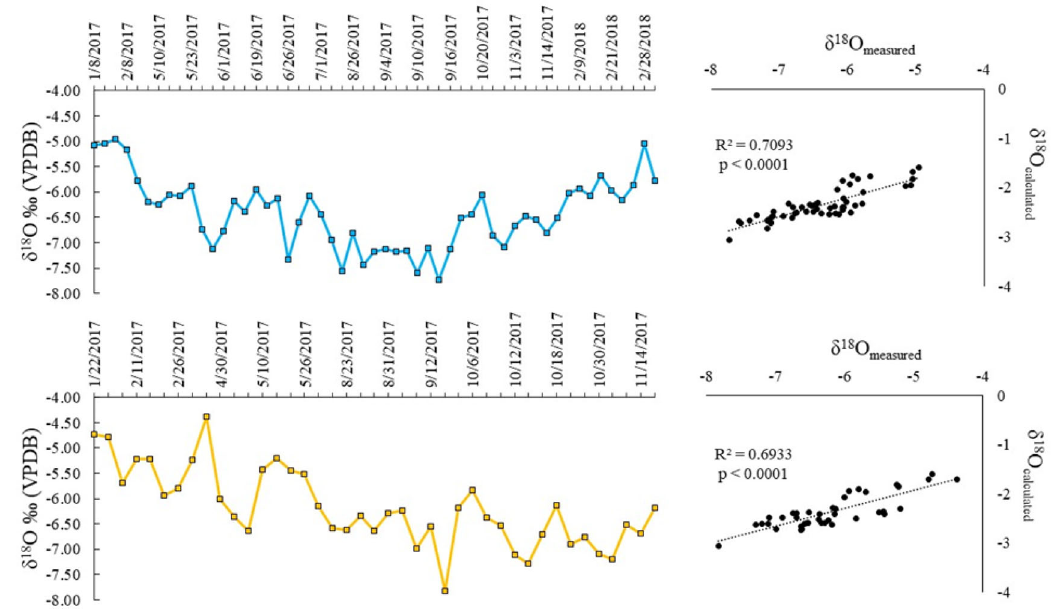
Fig. 3 Correlation of δ 18 O measured and δ 18 O calculated from modern shell specimens. The δ 18 O measured and δ 18 O calculated showed a highly correlated and signi fi cant relationship for both modern specimens (blue, CW1, n = 53; yellow, CW2, n = 41). Each data point represents the measured δ 18 O (per mil, VPDB) for a given calendar